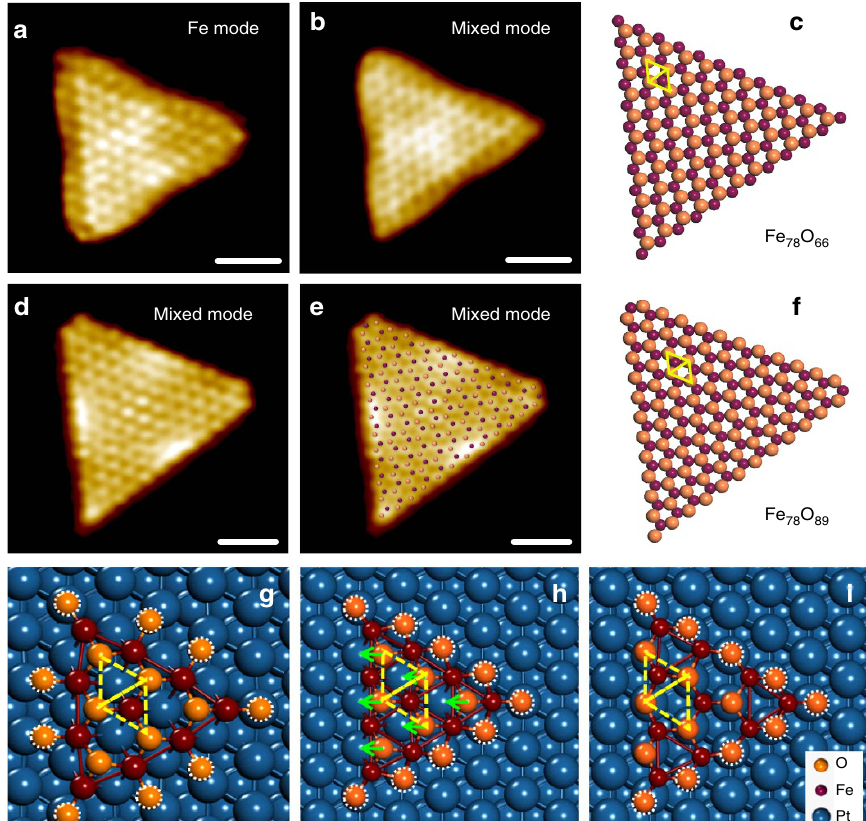
Figure 3 | The structural dynamics of FeO NSs in O 2 . ( a – f ) In situ STM images and the corresponding structural models of an Fe 78 O 66 NS before ( a – c ) and after ( d – f ) the exposure of 1 (cid:2) 10 (cid:3) 9 mbar O 2 at 270K. Element-specific STM images were used to identify the number of Fe and O atoms, as well as their relative positions. ( a , b ) are the Fe-mode and mix-mode STM images of the Fe 78 O 66 NS at 270K, which underwent a complete reconstruction in O 2 and turned into an Fe 78 O 89 island. ( d ) Mix-mode STM image of the Fe 78 O 89 island, which is overlayed with the structural model in e . In the mix-mode images, O atoms are resolved as bright protrusions and the hollow sites of the Fe lattice, which are not filled by O atoms, are resolved as dark depressions. The positions of dark depressions with respect to O atoms have changed after O 2 exposure, which is illustrated in the structural models in c , f , with colour representations of: Fe—purple, O—orange and Pt—blue. STM images were taken at 270K and scanning parameters are ( a ) V s ¼ þ 16mV, I t ¼ 4.3nA; ( b ) V s ¼ þ 34mV, I t ¼ 1.9nA; ( d ) and ( e ) V s ¼ þ 80mV, I t ¼ 1.8nA. Scale bars are 1nm for all STM images. ( g – i ) Calculated adsorption configurations of O atoms at the edges of an Fe 10 O 15 cluster on Pt(111). Among the three configurations, oxygen adatoms bind most weakly in g and most strongly in i . Compared with g , the configurations in h , i have energy gains of (cid:3) 2.10 and (cid:3) 2.79eV, respectively. To reach i , oxygen atoms in h need be shifted, with the moving directions marked by green